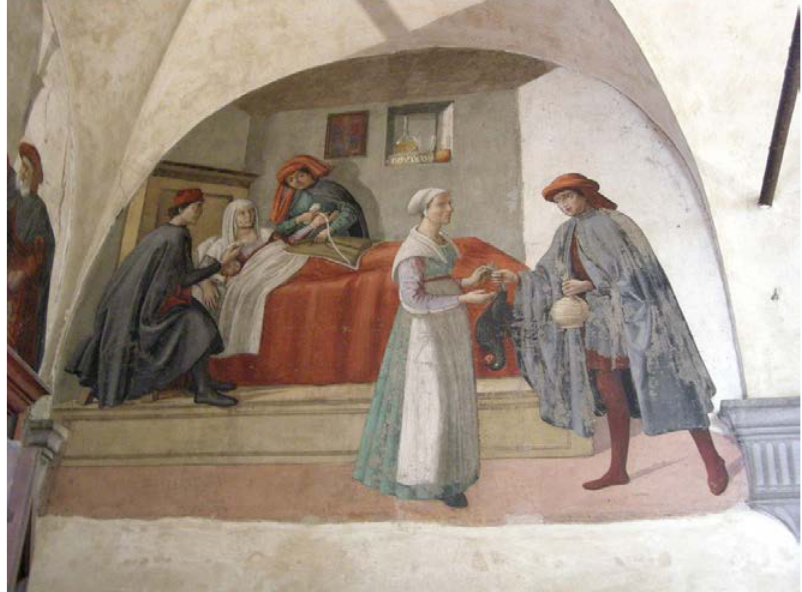
Figure 29 – Domenico Ghirlandaio e aiuti, Opere di misericordia: Visitare gli infermi , Firenze, Oratorio dei Buonuomini di San Martino, CC-BY-3.0, <https://upload. wikimedia.org/wikipedia/commons/6/63/Collaboratore_del_ghirlandaio_%28forse_